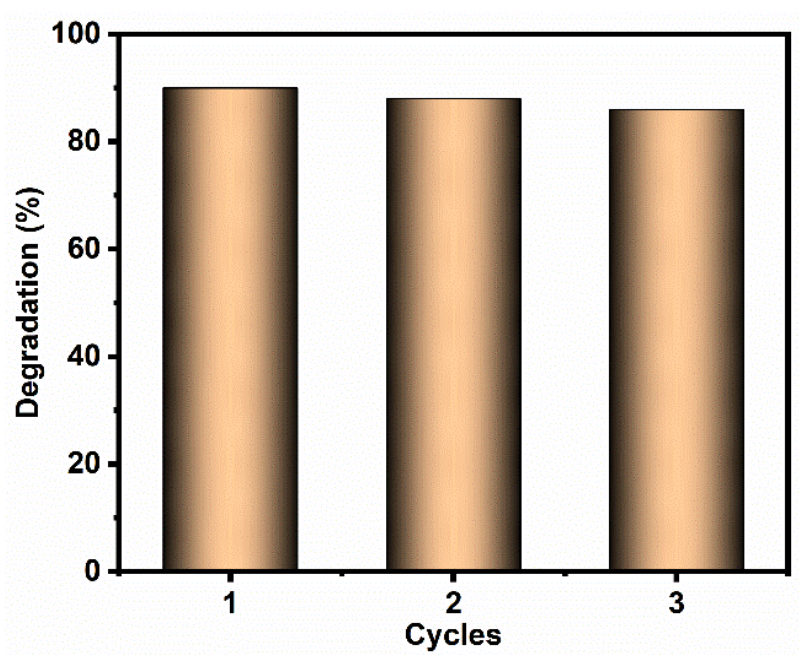
Figure 9. Photocatalytic stability studies of Cu/La/CeO 2 /GO Figure 9. photocatalytic stability studies of Cu/La/CeO 2 /GO nanocomposites.